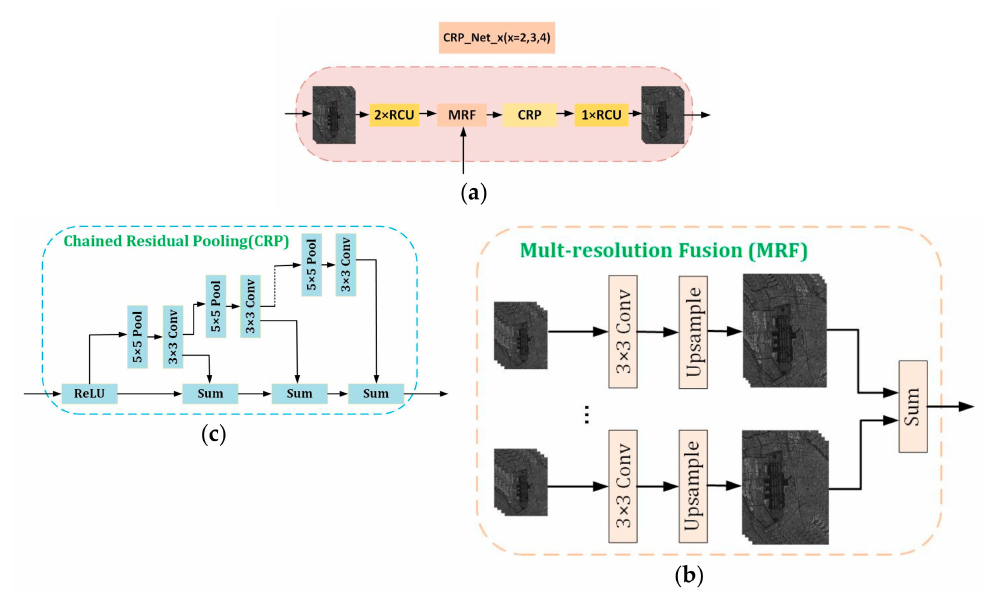
Figure 6. The internal structure of CRP_Net_x. ( a ) is the overall structure of CRP_Net_x; ( b ) is the MRF structure; ( c ) is the Chained Residual Pooling (CRP) structure.